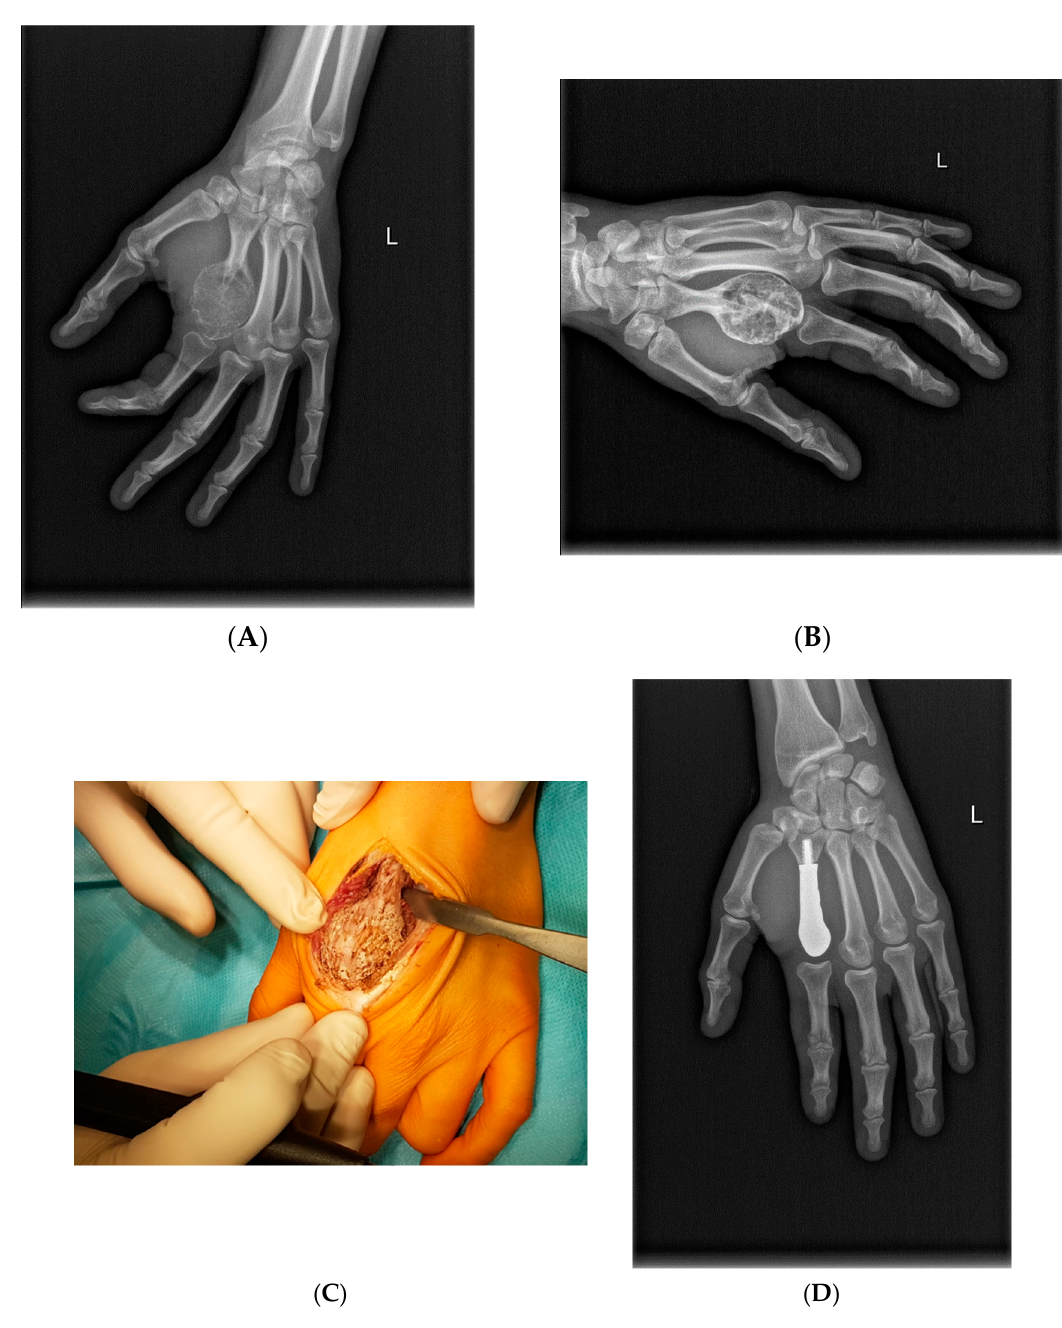
Figure 5. Response to denosumab therapy and radical resection of the GCTB of the second metacarpal followed by reconstruction with a 3D ‐ printed patient ‐ specific implant. ( A ) GCTB of the second metacarpal at the beginning of therapy; ( B ) X ‐ ray taken after 13 doses of denosumab treatment; ( C ) Intraoperative image showing well ‐ calcified tumor after dissection of surrounding soft tissue envelope; ( D ) 3D ‐ printed patient ‐ specific implant.